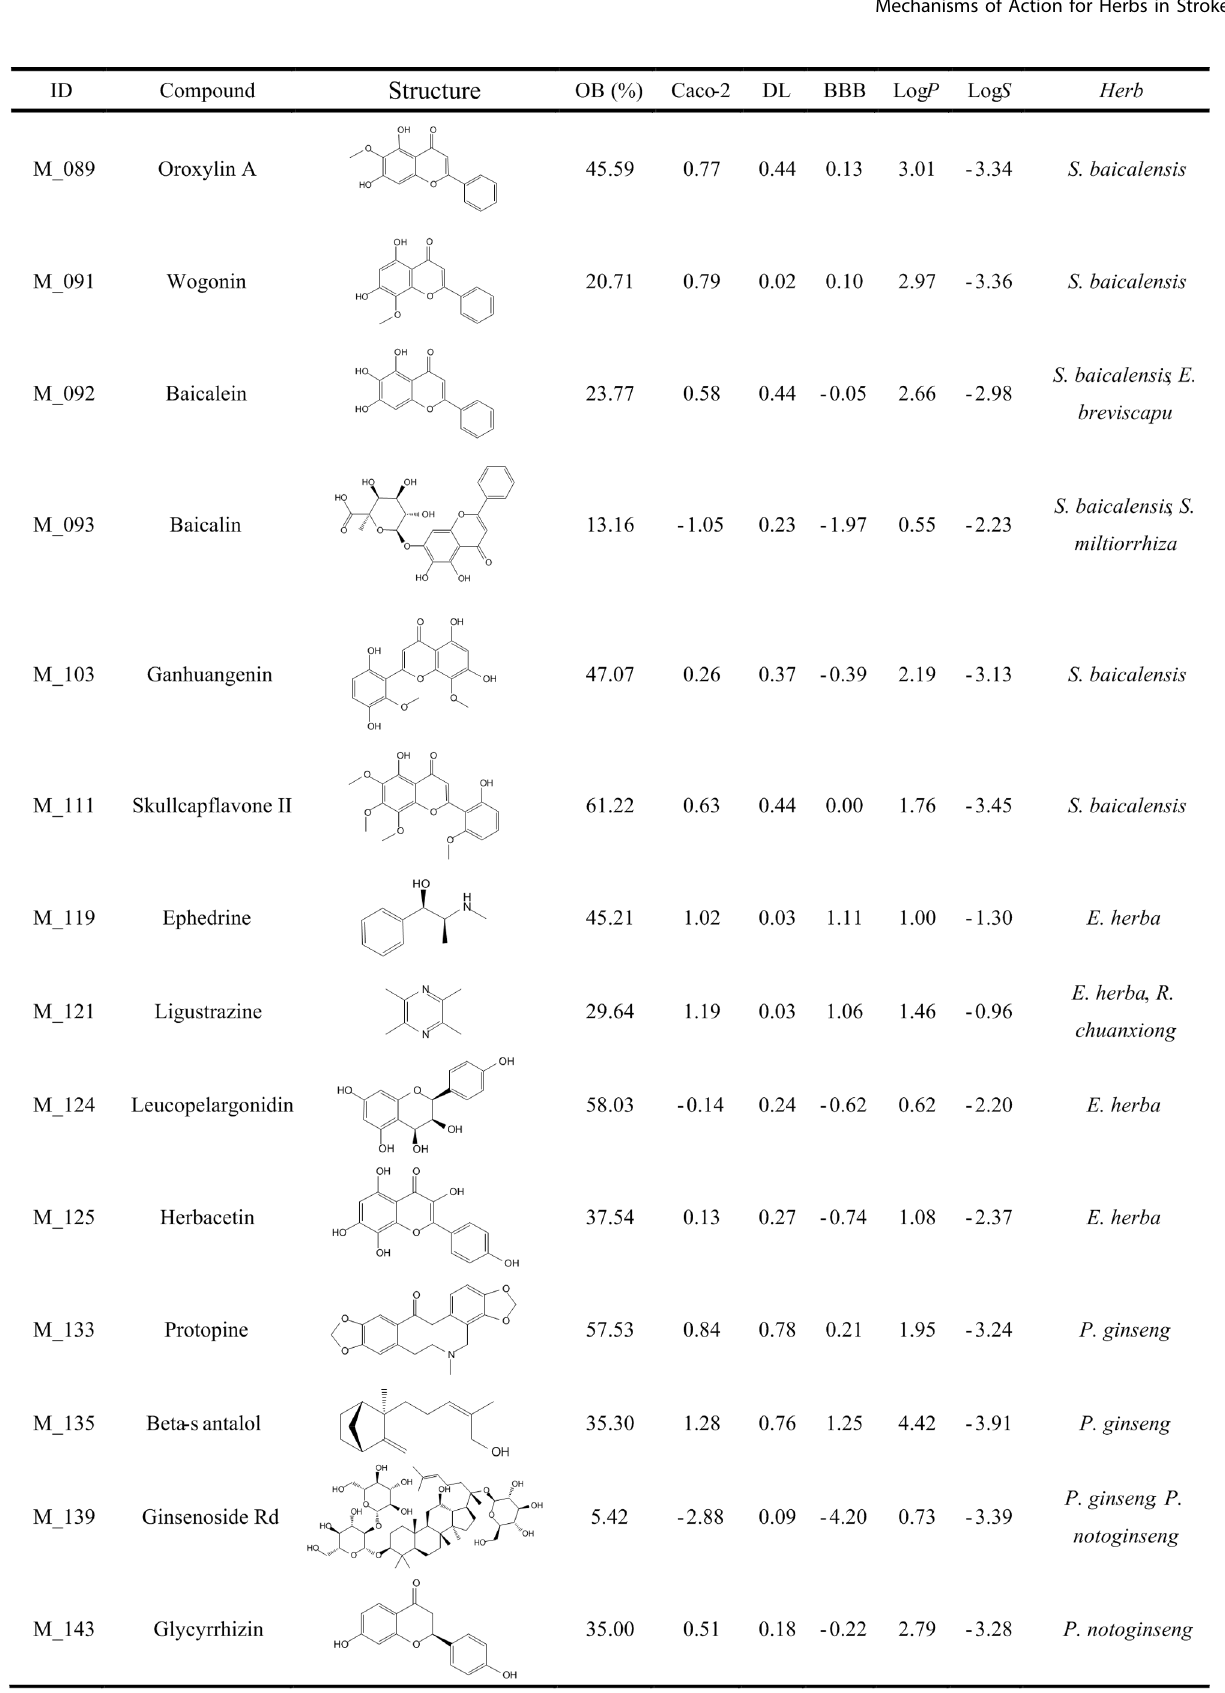
Figure 3. Representative active constituents of anti-stroke herbs and their corresponding ADME parameters (Part 3). doi:10.1371/journal.pone.0102506.g003 PLOS ONE |